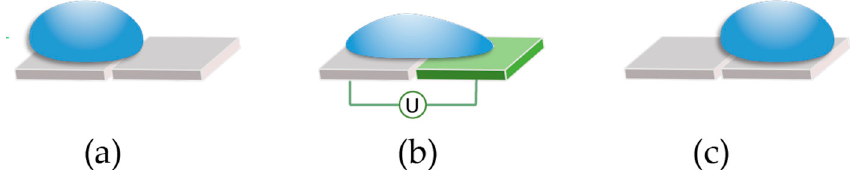
Figure 5. EWoD explained. ( a ) The usual shape of a droplet in the absence of voltage. The electrode underneath is coated with a hydrophobic layer, thus the droplet does not wet the surface; ( b ) Electrical voltage unbalances the force equilibrium at the solid-liquid-vapor interface, causing the droplet to wet the surface; ( c ) Consequently, the droplet moves towards the charged electrode.